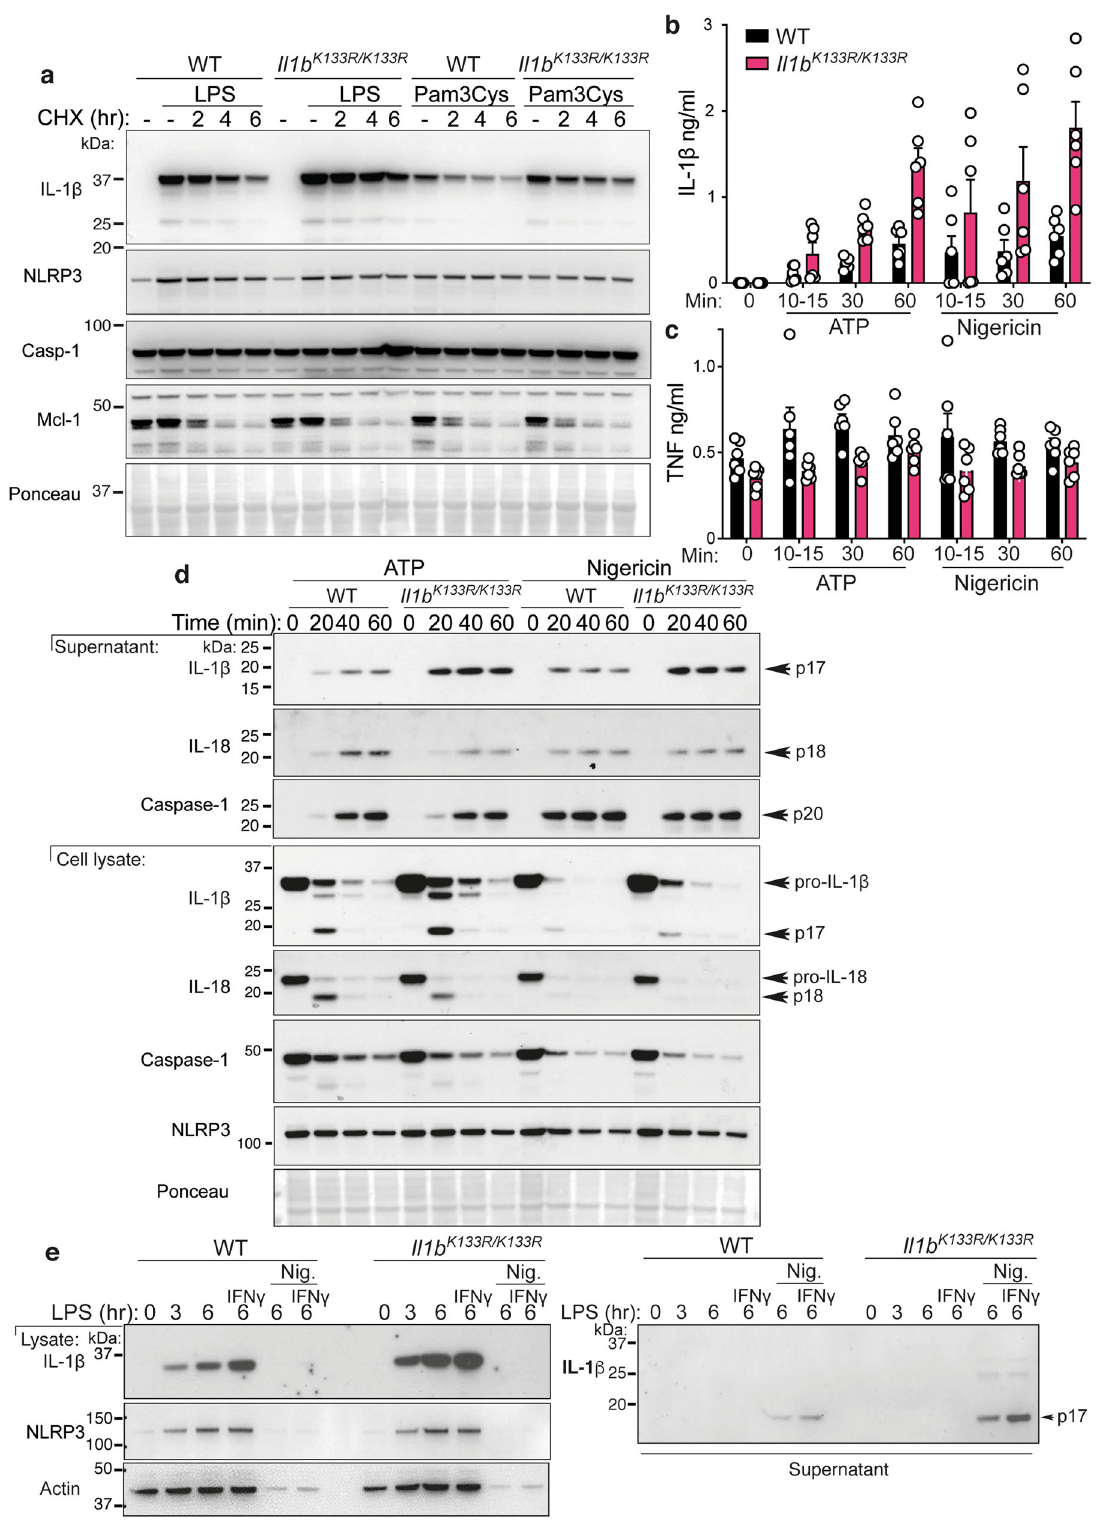
Our mass-spectrometry analysis identi fi ed IL-1 β K133 as being targeted for ubiquitylation. Consistent with IL-1 β K133 ubiqui- tylation contributing to its proteasomal targeting, IL-1 β K133R expressing 293T cells, as well as macrophages and neutrophils derived from Il1b K133R/K133R mice, expressed increased levels and reduced turnover of precursor IL-1 β . As such, more bioactive IL- 1 β was generated and released from Il1b K133R/K133R macrophages,